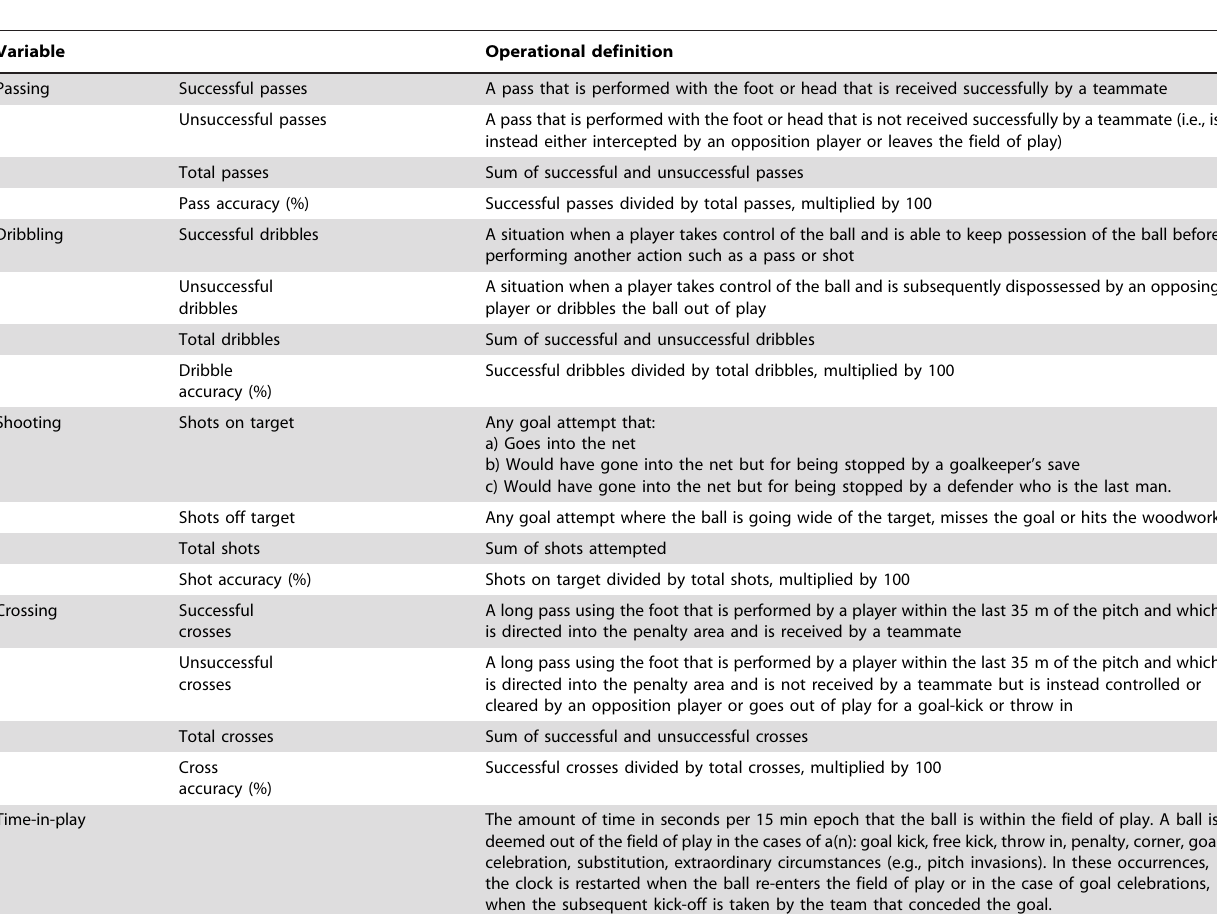
Table 1. Operational definitions of the technical variables analysed (derived from Rampinini, et al. [4] and Opta Sports Data).